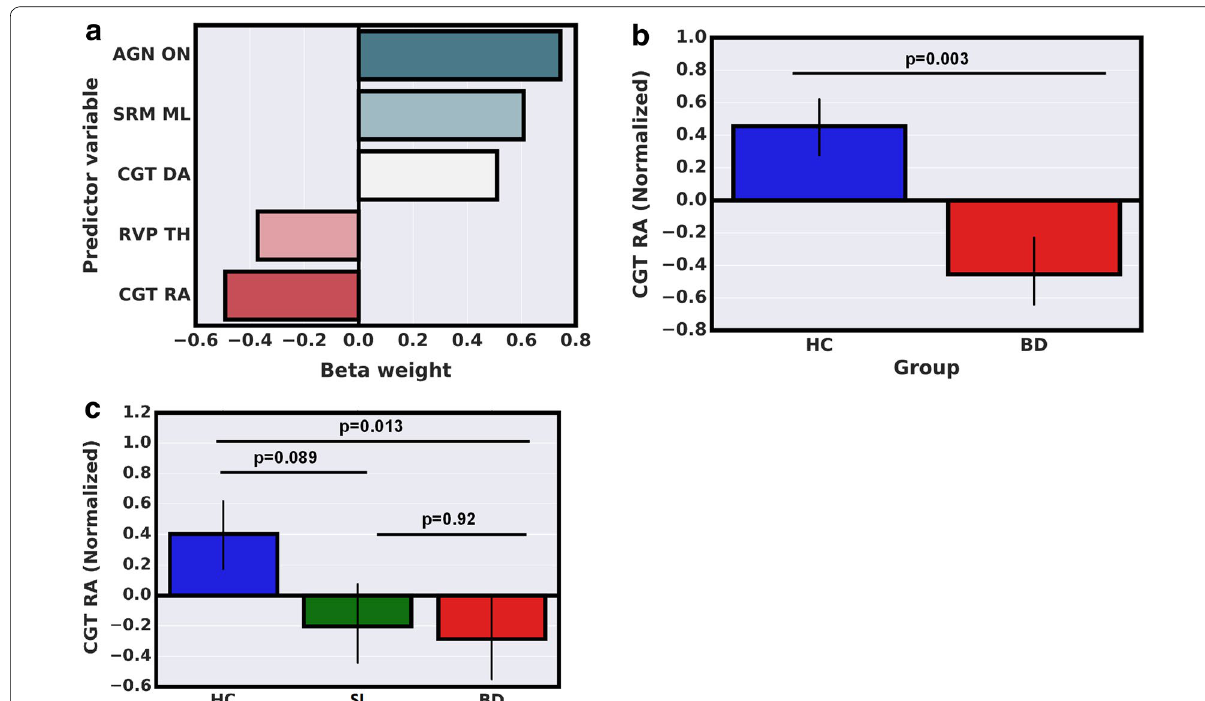
Fig. 3 a A bar graph showing LASSO algorithm coefficients assigned to the most relevant CANTAB neurocognitive measurements. AGN ON affec‑ tive Go/No go task total omission with negative stimuli, SRM ML spatial recognition memory task mean latency, CGT DA Cambridge gambling task delay aversion, CGT RA Cambridge gambling task risk adjustment, RVP TH rapid visual processing task total hits. These neurocognitive variables were assigned as non‑zero coefficients during algorithm training. Positive coefficients represent increased neurocognitive scores in BD patients as compared to HCs and vice versa. b A bar graph comparing CGT RA scores from the discovery cohort. c A three‑group (HCs, SIs, BD) comparison